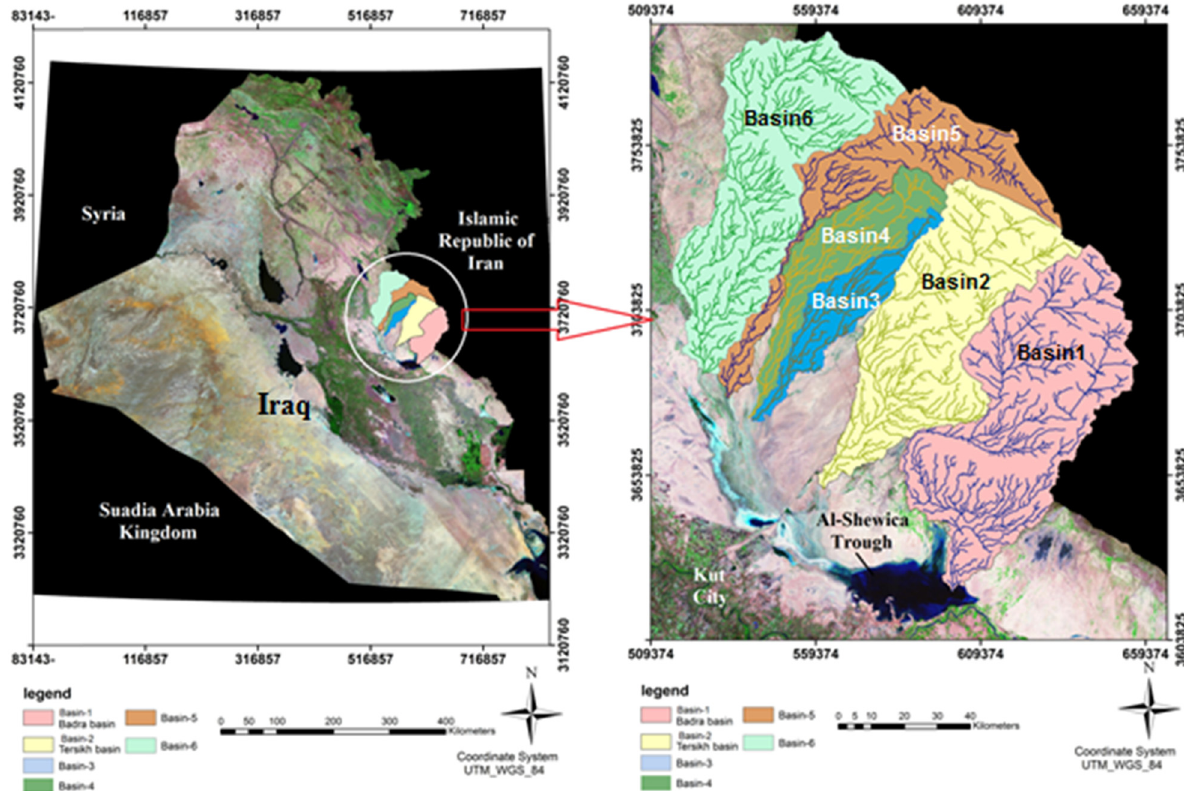
Figure 2: Location map of the study area with stream networks [ 15 ]